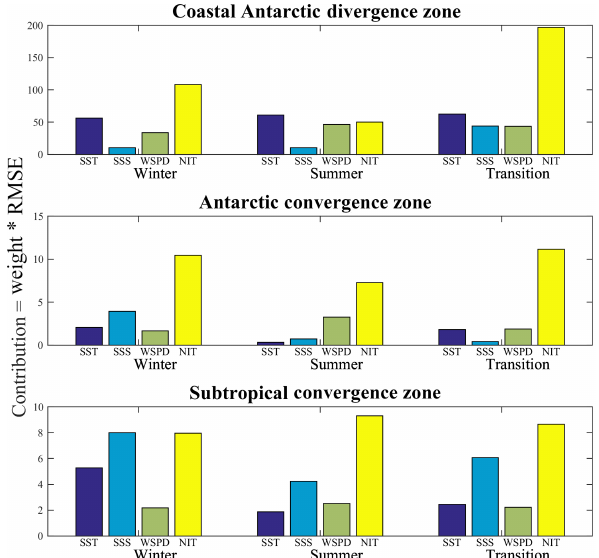
Figure 16. Contributions to the p CO 2sw bias in the model from SST, SSS, wind speed (WSPD) and nitrate (NIT) in the winter, sum- mer, and transitional regimes. The Southern Ocean is differentiated into the coastal Antarctic divergence zone (roughly polewards of 60 ◦ S), Antarctic convergence zone (roughly 60–50 ◦ S), and sub- tropical convergence zone (roughly 50–40 ◦ S) to better account for regional differences in the model biases and obtain better linear fit for the computation of the weights in Eq. (6) (see Fig.